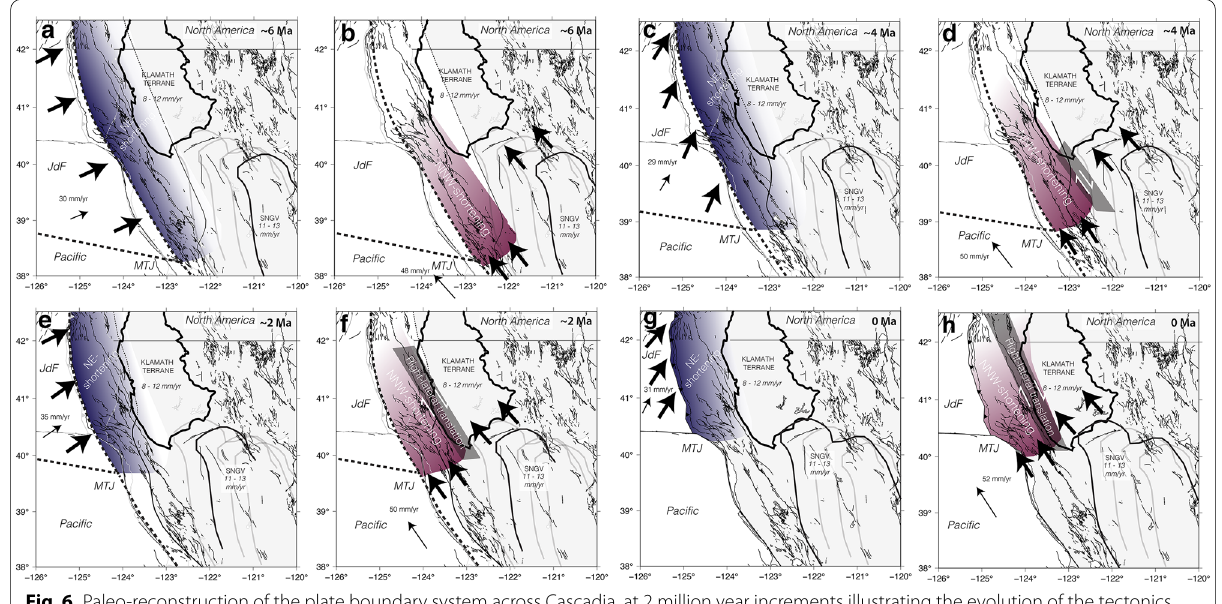
Fig. 6 Paleo-reconstruction of the plate boundary system across Cascadia, at 2 million year increments illustrating the evolution of the tectonics of southern Cascadia. Maroon shading shows the approximate region of NNW-shortening, blue shading shows the approximate region of subduction-related upper-plate shortening and gray shading outlines regions experiencing right-lateral translation. The paleo-shorelines shown in the ~ 6–5 Ma reconstructions are interpolated from Lock et al. (2006). The SNGV block location is based on Faulds and Henry (2008). a , b ~ 6 Ma reconstructions. c , d ~ 4 Ma reconstructions. e , f ~ 2 Ma reconstructions. g , h 0